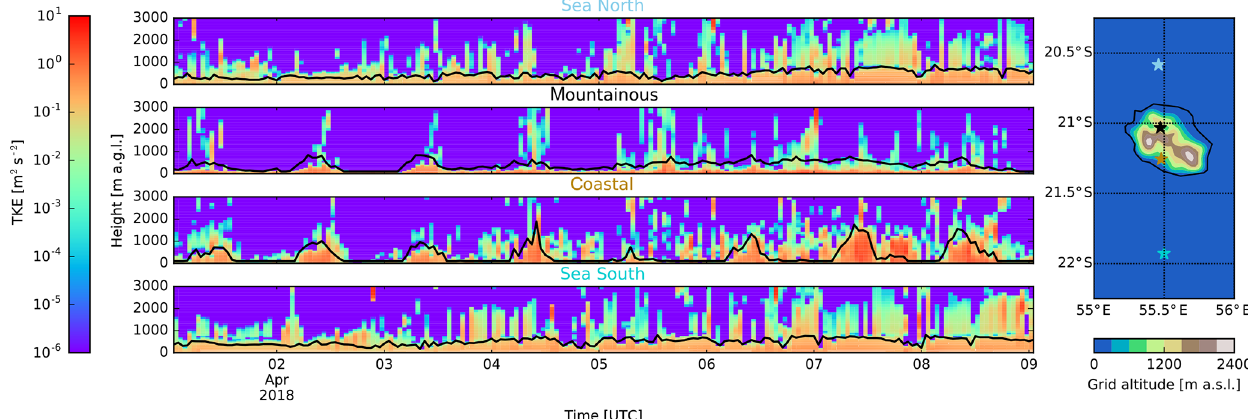
Figure 1. Temporal evolution of TKE fields retrieved from AROME in four different types of area around Réunion overlaid with a black curve showing the PBL top as calculated in FLEXPART. The vertical evolution plots on the left correspond from top to bottom with the locations indicated on the map from north to south, respectively. Height of the vertical profiles is expressed in meters above ground level; over the mountainous and coastal areas this corresponds to an added 1.2 and 0.4km above sea level,